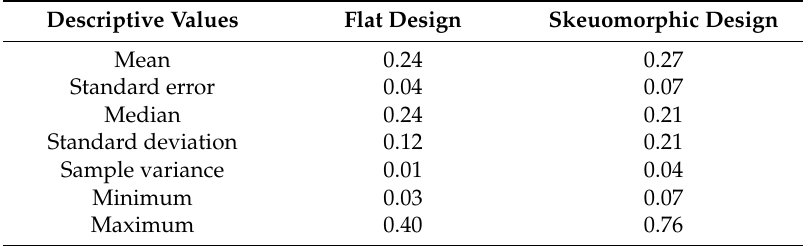
Table 4. First fixation duration.